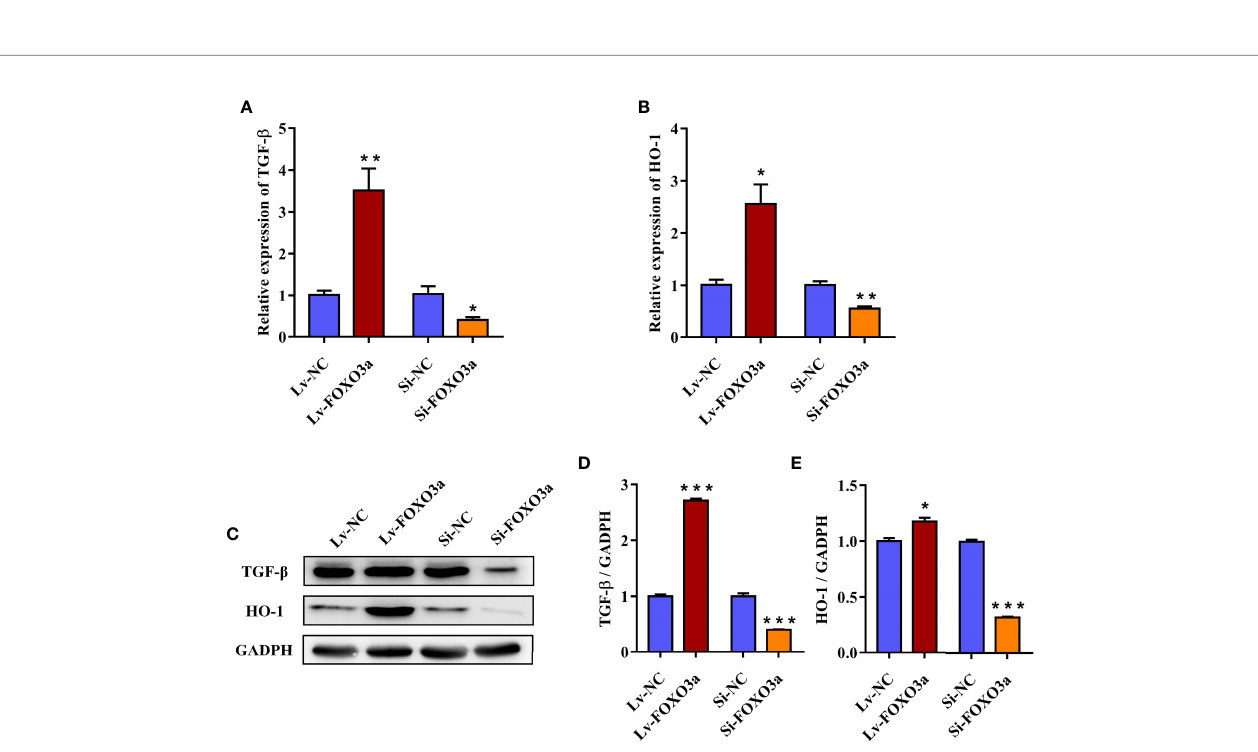
FIGURE 4 | FOXO3a regulates TGF- b and HO-1 in Jurkat cells. (A, B) The mRNA levels of TGF- b and HO-1 were obviously increased by Lv-FOXO3a, but markedly decreased by Si-FOXO3a. (C) Representative immunoblots of TGF- b and HO-1 protein. (D, E) Quanti fi cation for TGF- b and HO-1. All data were expressed as mean ± SEM of three independent experiments (n = 3). The differences between experimental group and NC group were analyzed using Student ’ s t-test. * P < 0.05, ** P < 0.01, *** P < 0.001 versus NC group. Lv-NC, lentivirus negative control, Lv-FOXO3a, FOXO3a overexpression; Si-NC, siRNA negative control; Si-FOXO3a, FOXO3a knockdown.